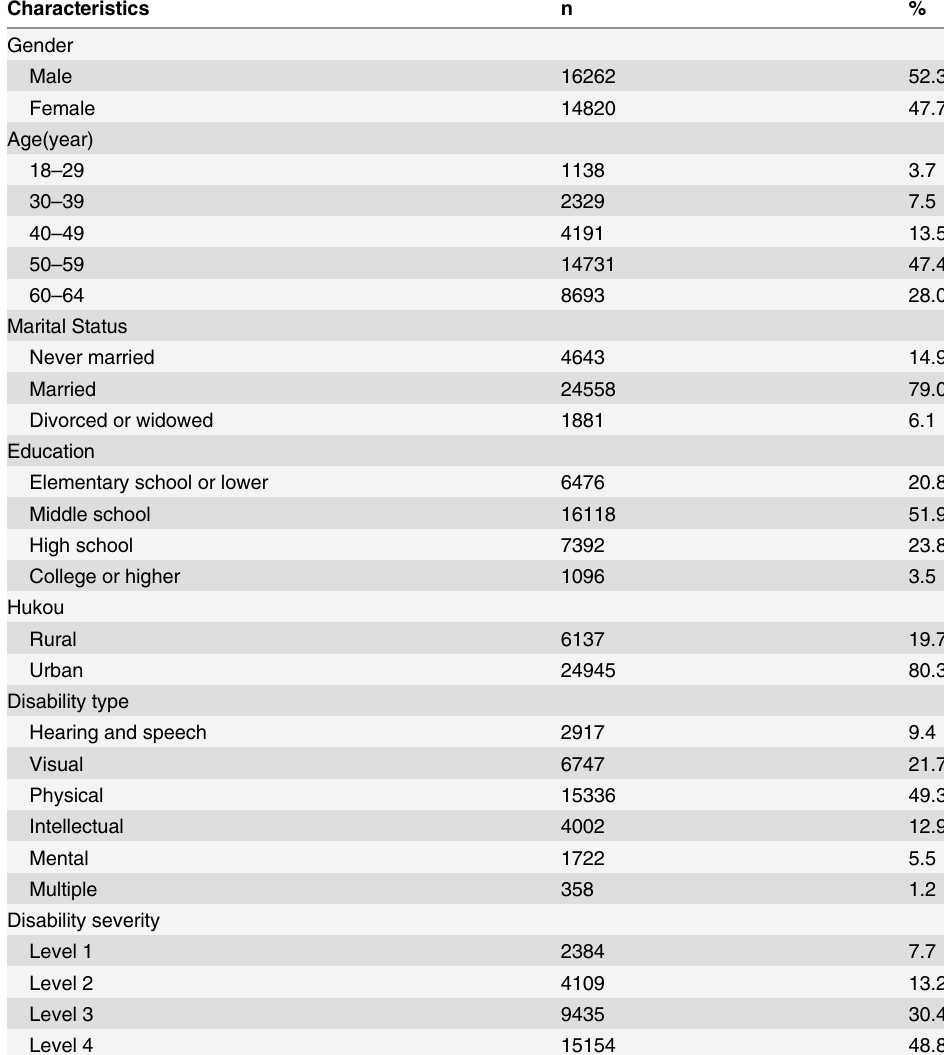
Table 1. Demographic and disability characteristics of